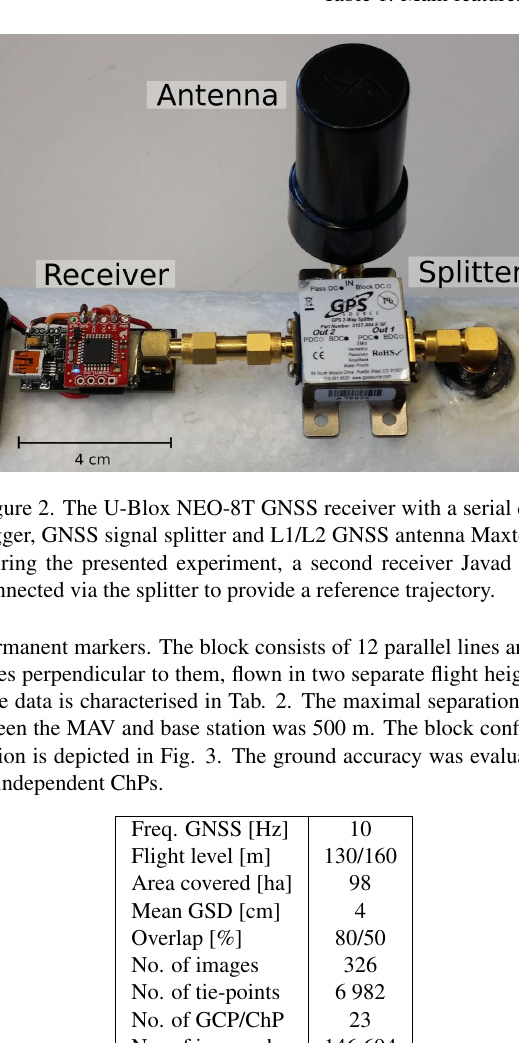
Table 1. Main features of the employed GNSS receivers.